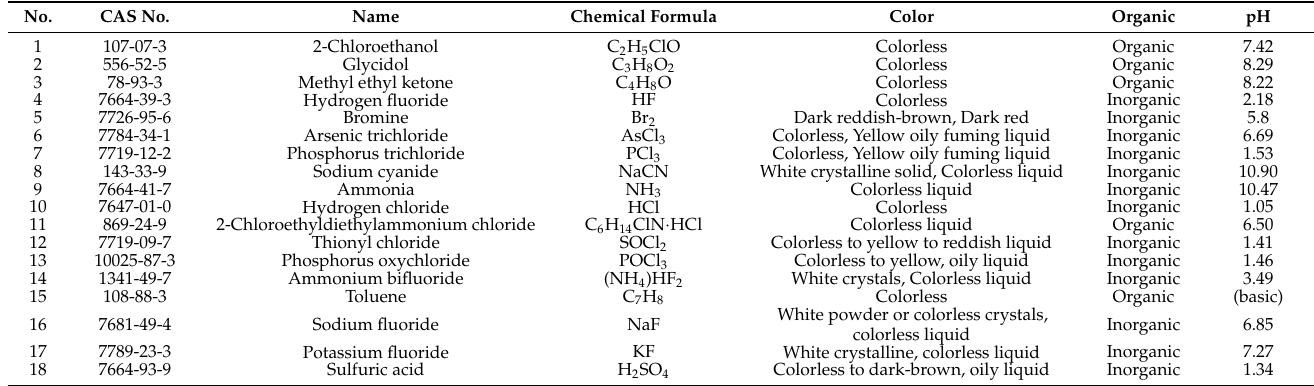
Table 1. Hazardous chemicals used to build a spectral library.